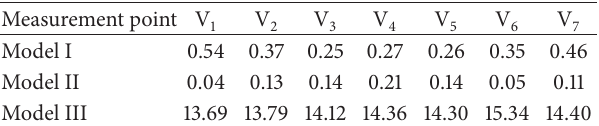
Table 4: Velocity amplitudes at V (mm/s).